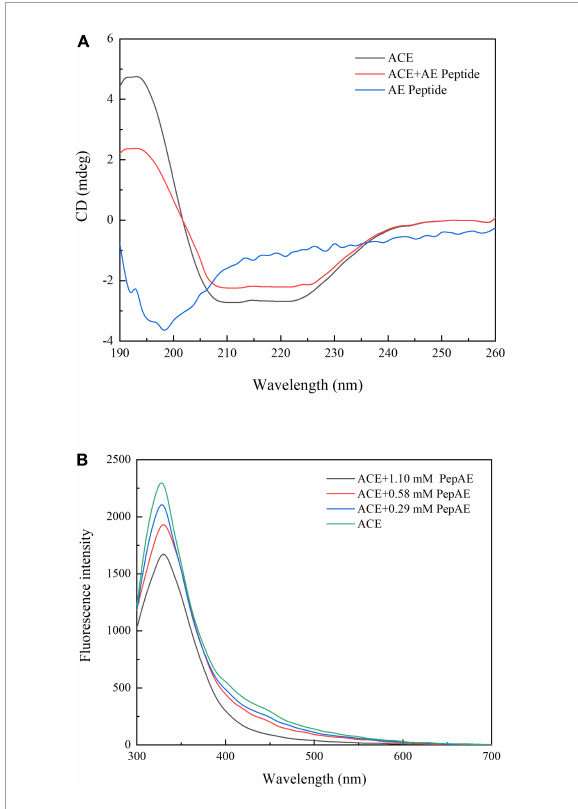
FIGURE6 (A) Far-UV CD spectra results of the peptide AEYLCEAC as well as ACE in the absence or presence of AEYLCEAC. The mass ratio of ACE: peptide was about 7:1. (B) Fluorescence emission spectra results of ACE with increasing concentrations of peptide AEYLCEAC (0.29, 0.58, 1.1